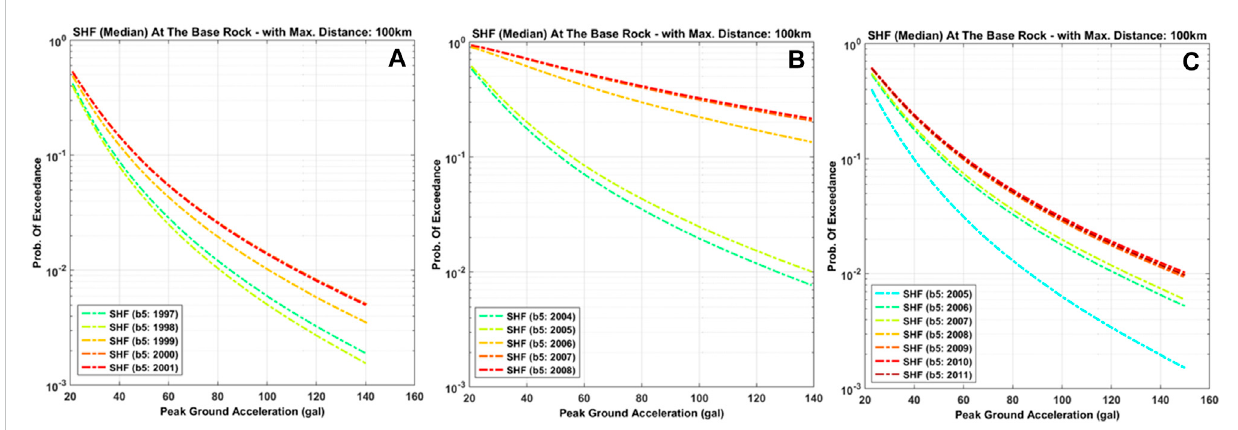
FIGURE 6 PSHFbeforeM7.9of2000 (A) ,M8.5of2007 (B) ,andM7.8of2010 (C) asafunctionofb(t).Itshowstheconsistencybetweenalargepositivegradient of δ AIC and an increase in the PSHF at each certain probability exceedance (PE) level before the great earthquake event. It consistently happened for the three events that were